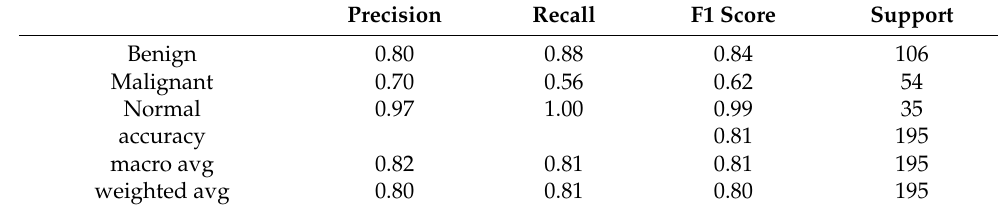
Table 2. Precision, Recall, and F1 score for the masked image on 25% of test data. Figure 5. Model architecture for Masked images.